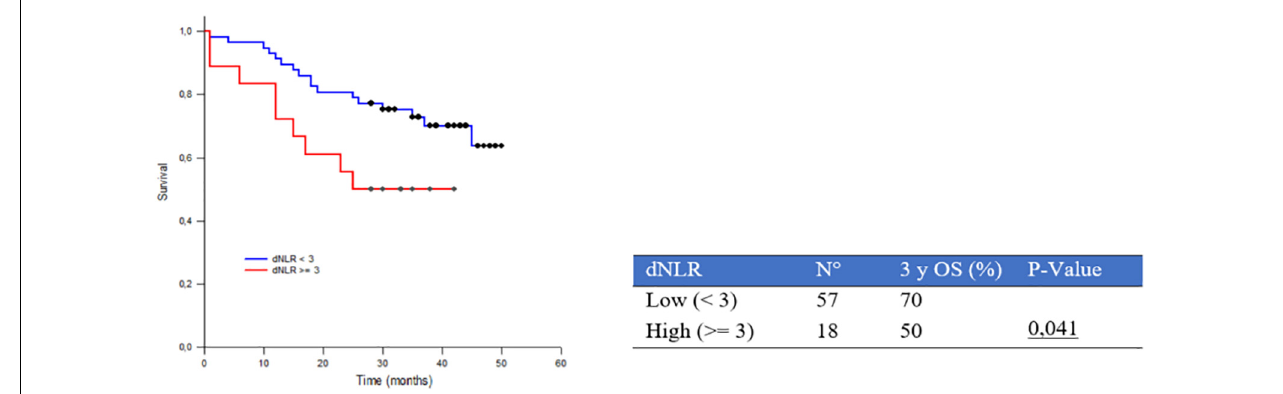
FIGURE 6 | Three-year survival rate (3yOS) data and curves according to low and high derived neutrophil/lymphocyte ratio (dNLR) [absolute neutrophil count/(white blood cell concentration-absolute neutrophil count)].